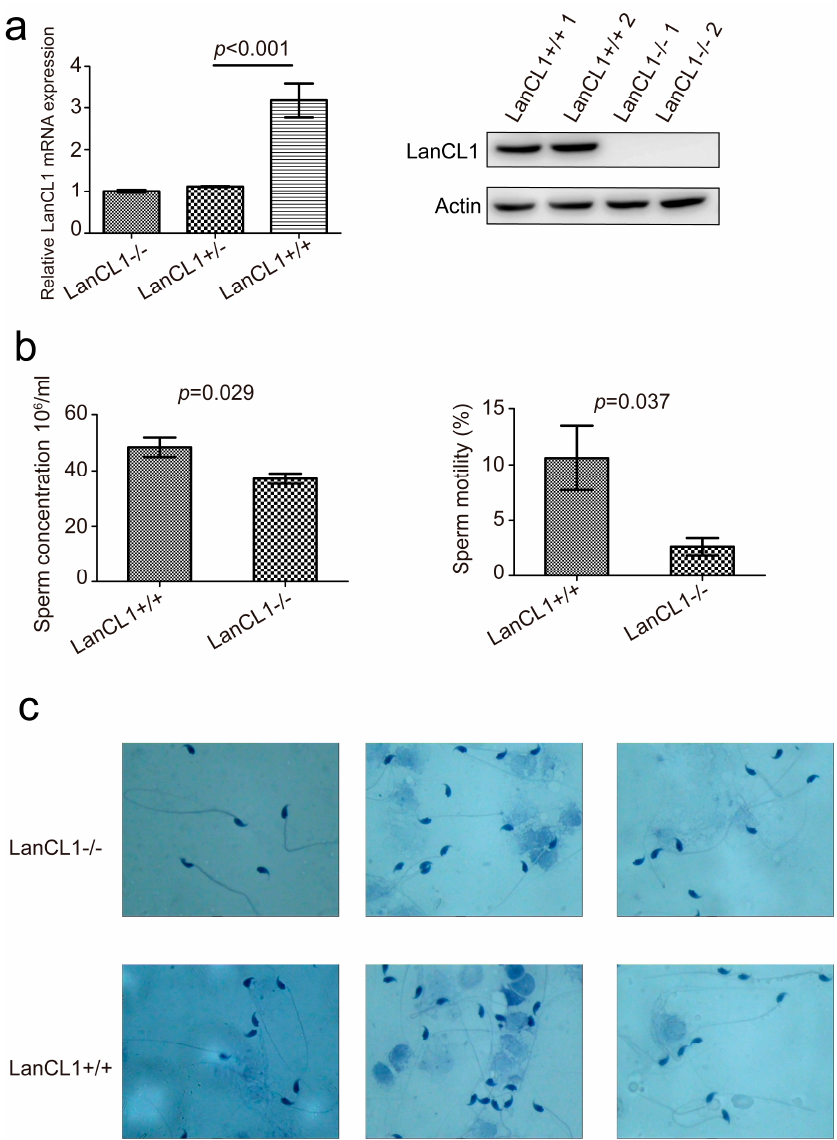
Figure 1. LanCL1 gene knockout influences the semen quality. ( a ) The expression of mRNA and protein in the LanCL1+/+, LanCL1+/ − and LanCL1 − / − mice. ( b ) Parameters of semen quality in the LanCL1+/+ and LanCL1 − / − mice. ( c ) Sperm morphology.